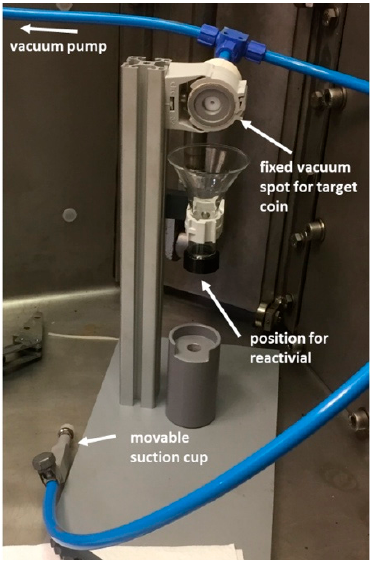
Figure 3. Representative picture of the setup used in the hot cell to open the irradiated targets received from the Bern cyclotron laboratory.